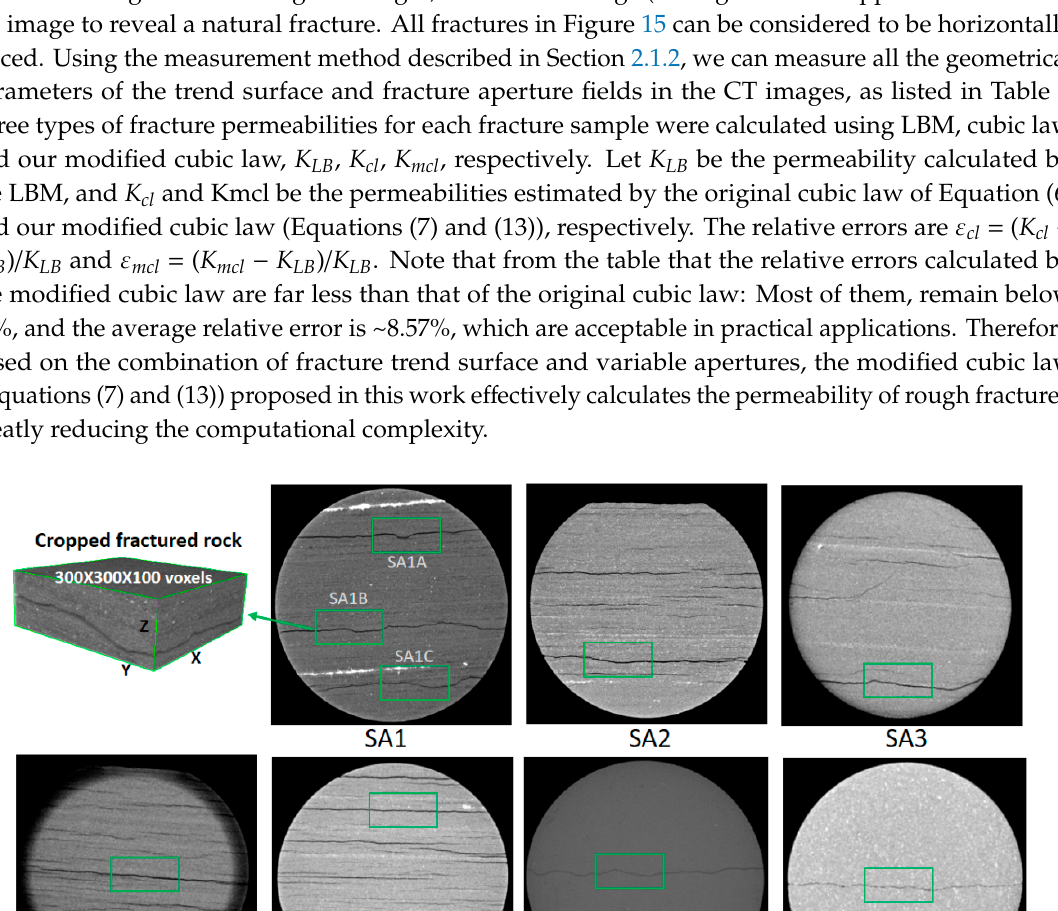
Figure 14. The fitted surface for the data of triple ( f T , f b , f ) with the equation of Equation (13).